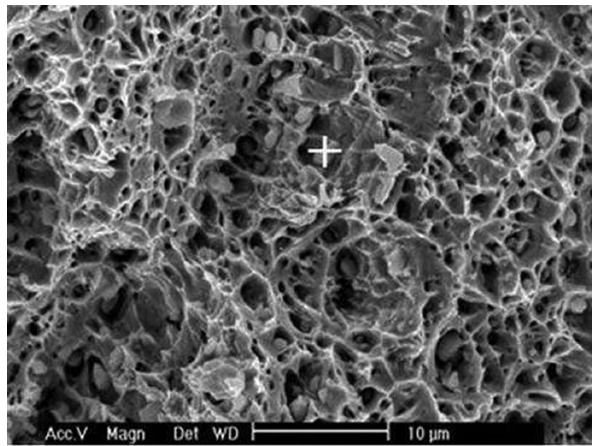
Figure 2 Fracture appearance of the composite.